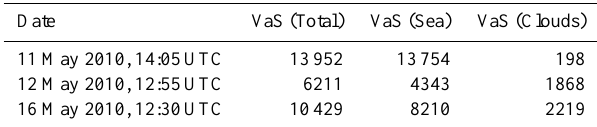
Table 5. Independent SO 2 validation sets divided into clouds over sea and clouds over meteorological